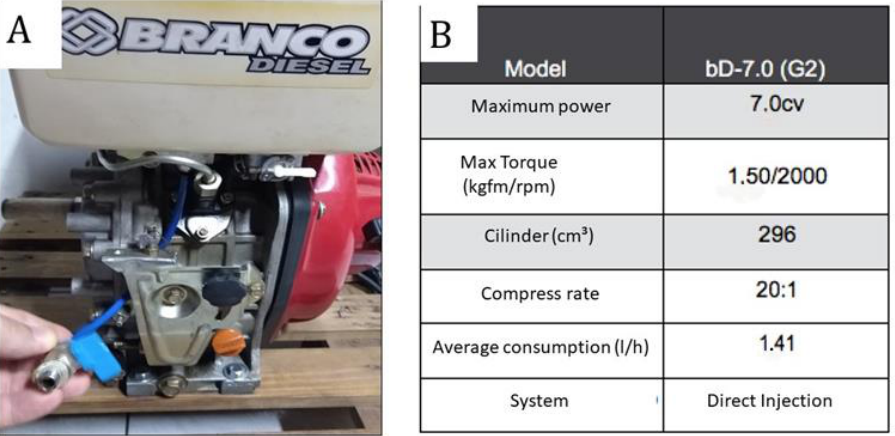
Figure 3. A — Photograph of the engine; B — Technical specifications of the engine (source: the au-